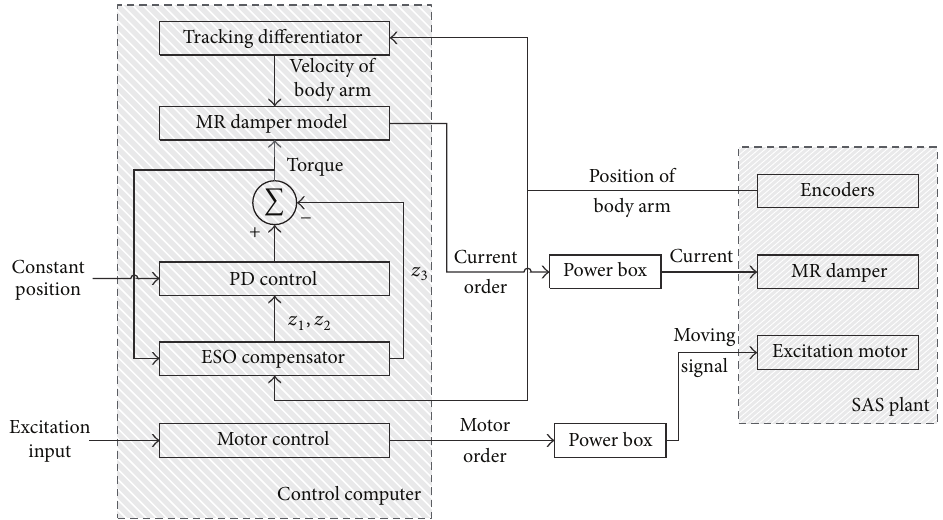
Figure 9: The control structure diagram of the